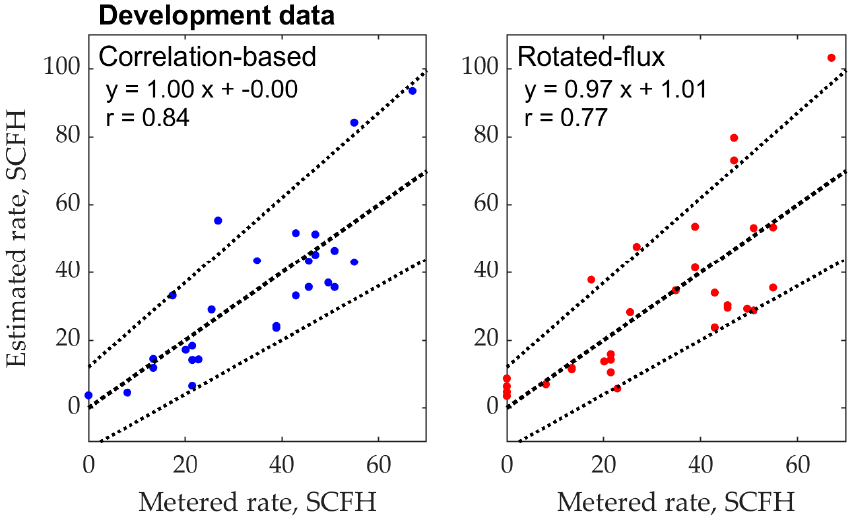
Figure 9. Leak rate performance using the ( left ): correlation-based method and ( right ): rotated-flux method for 33 scenarios. Dashed lines represent the 1:1 relationship and bounds for ± 12 SCFH ± 25%. The correlation-based method is forced though 0 for the development dataset as described in the text.